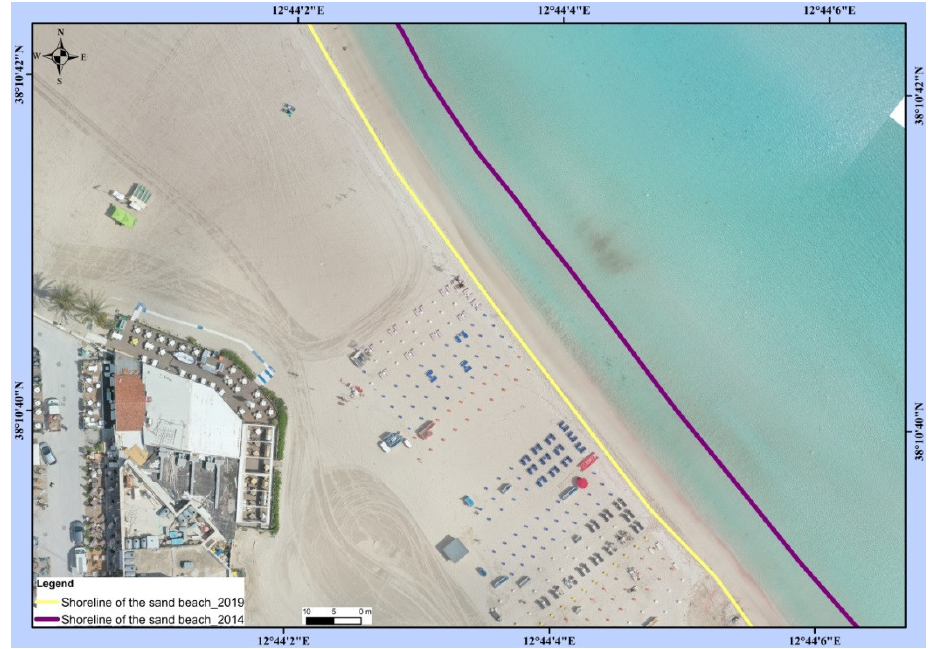
Figure 6. Map of 2019 and 2014 sand beach shorelines positions overlapped on the UAV orthomosaic image acquired on 28 May 2019 on the coast of San Vito Lo Capo. The 2019 shoreline was extracted on UAV orthomosaic, whereas the 2014 shoreline was extracted from the GeoEye-1 satellite image.